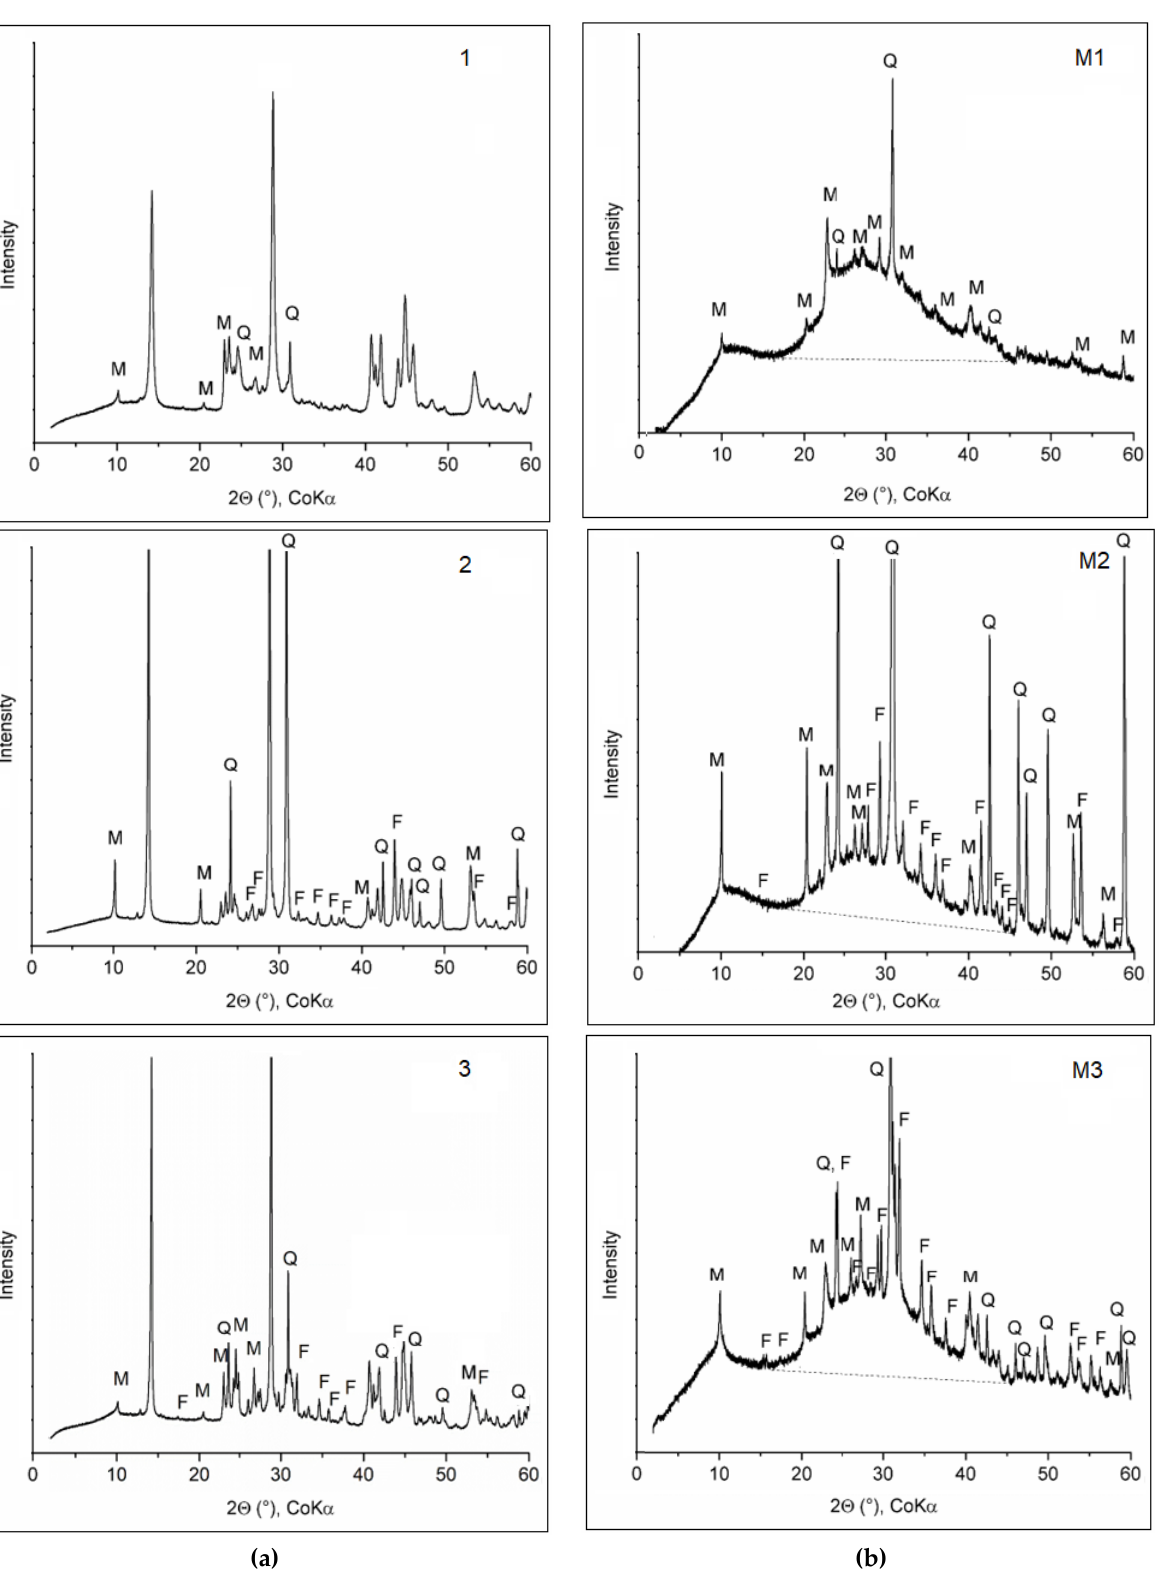
Figure 2. XRD patterns of: ( a ) kaolin samples 1–3 (for clarity, peaks of kaolinite are unmarked) and ( b ) metakaolin samples M1, M2 and M3. Q—quartz, M—muscovite, F—orthoclase. Metakaolinite peaks halo was separated from the background by a dotted line.